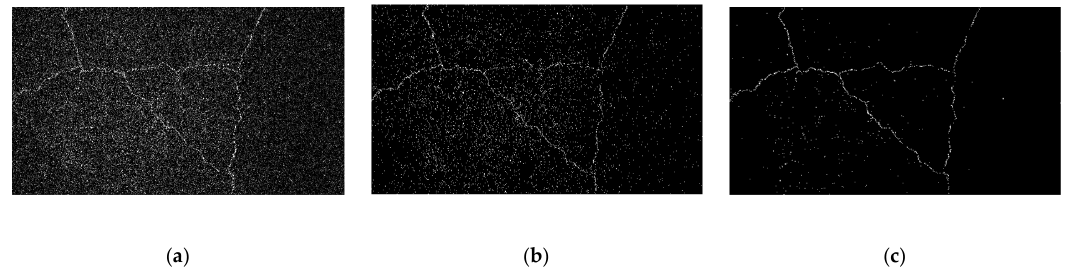
Figure 9 . ( a ) Enhanced edge, ( b ) first-level binary, and ( c ) second-level binary images; defected dataset, spatial domain, and Gaussian filter